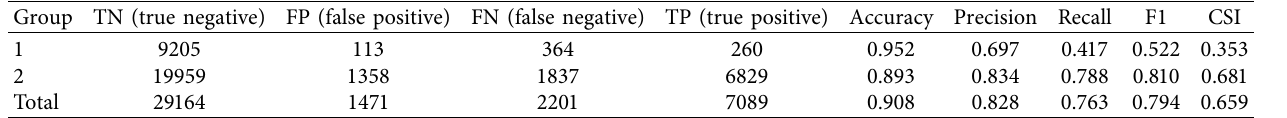
Table 7: Results by group with XGBoost using weather and geographic variables.